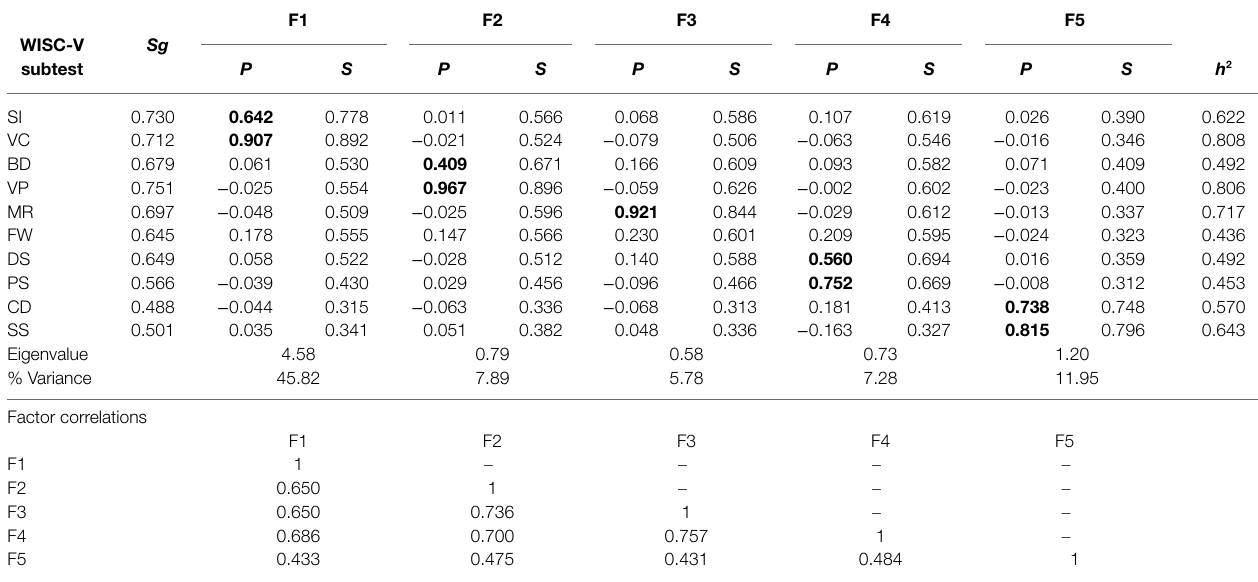
TABLE 2 | Exploratory factor analysis of the 10 WISC-V primary substests: Five-factor model solution (oblique) with promax rotation for the EFA sample ( n = 823).